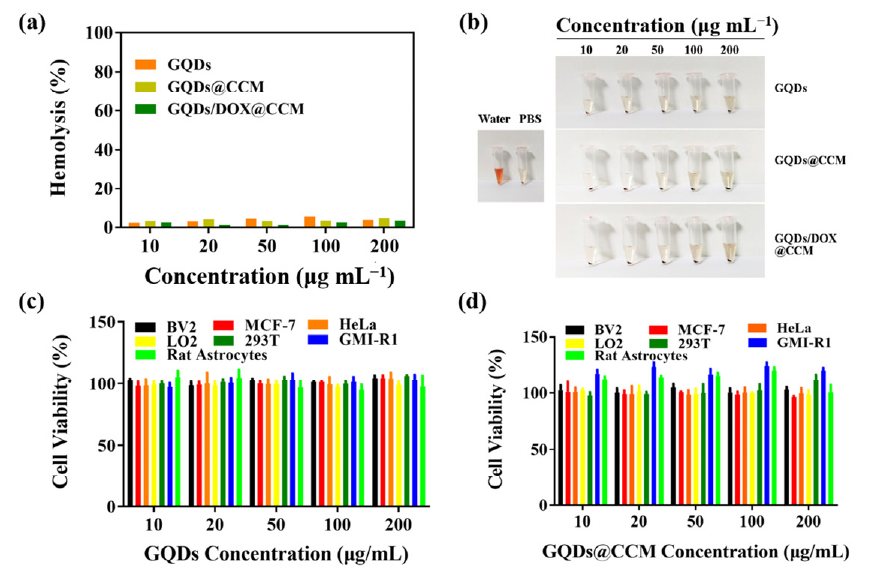
Figure 4. Biocompatibility in vitro. ( a , b ) Hemolysis quantification of red blood cells incubated with deionized water, PBS, GQDs, GQDs@CCM, and GQDs/DOX@CCM. ( c , d ) Cytotoxicity of GQDs and GQDs@CCM to various cell lines with different concentrations for 24 h.